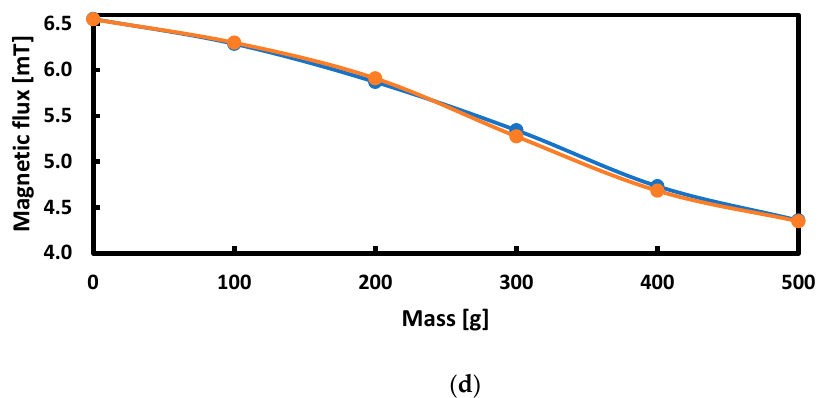
Figure 11. Hysteresis curves for: ( a ) voltage, ( b ) noise, ( c ) phase shift, and ( d ) magnetic flux measure- ments depending on the weight loading the plate.